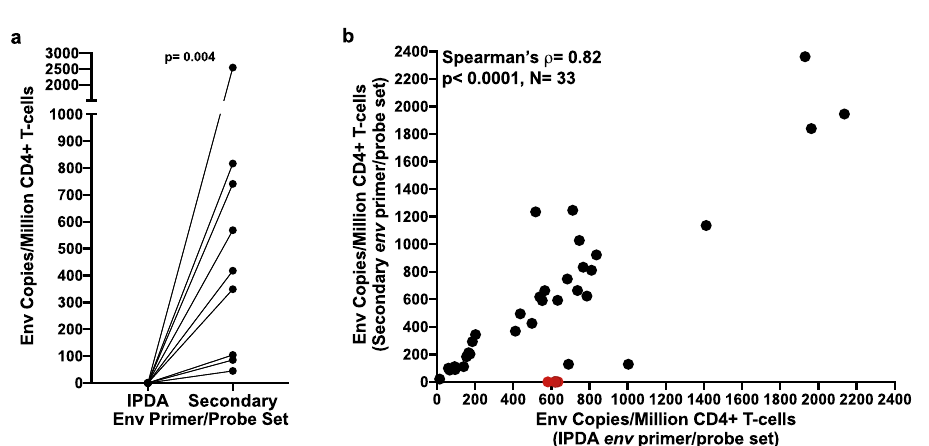
Fig. 3 HIV sequence-speci fi c optical bleed-through prohibits tight thresholding on negative populations. a 2D and env 1D plots of OM5346 virus 3 Ψ region sequence when tested as a synthetic DNA gene fragment (Virus 3 Ψ gBlock) without corresponding env template. Minimal Ψ - to env - channel spillover occurs and the positive droplet threshold can be drawn tightly to the double-negative population without consequence (note the presence of one false double-positive droplet). b 2D and env 1D plots of OM5346 virus 4 Ψ region sequence, tested as a synthetic DNA gene fragment (Virus 4 Ψ gBlock), without corresponding env template. Drawing a tight threshold causes optical bleed-through of Ψ (FAM) fl uorescence into the env (VIC) channel to yield a false-positive env (and by extension, false-positive intact) signal. c 2D and env 1D plots of OM5346 Virus 4 Ψ region sequence, tested as a synthetic DNA